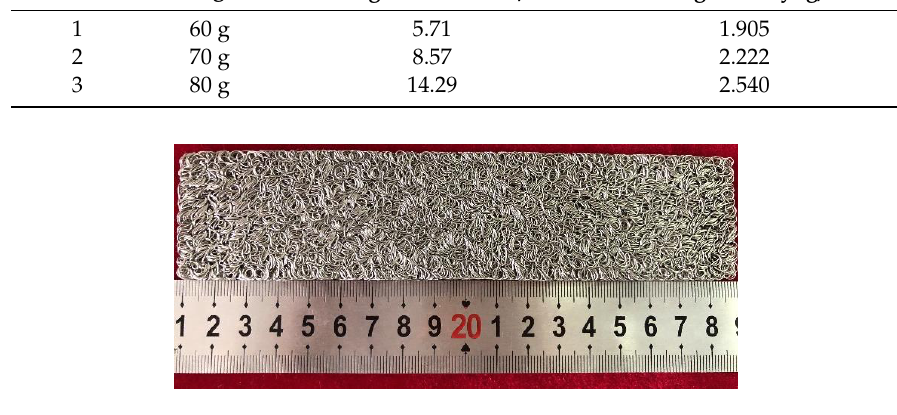
Figure 1. Plate-like EMWM specimen.